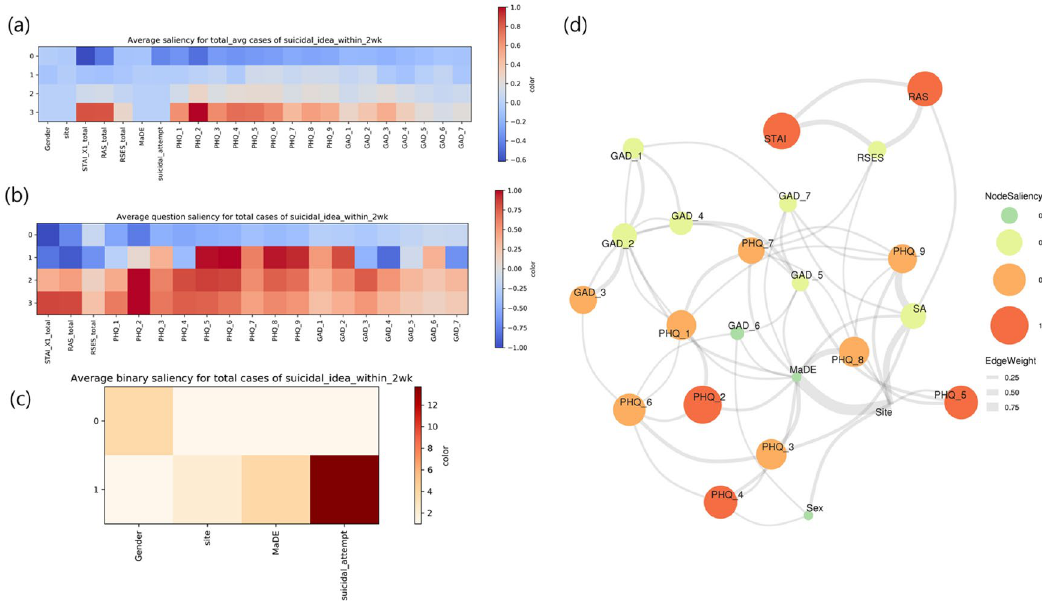
Figure 2. Attention plots: ( a ) Raw averaged attention plots, ( b ) Attention plot comparing the questionnaire items, ( c ) Attention plot comparing the binary items, ( d ) Attention plot for the mixed Gaussian model-based graphical network (generated with the “mgm” R package for visualization) for the questionnaire items on the test set ( n =